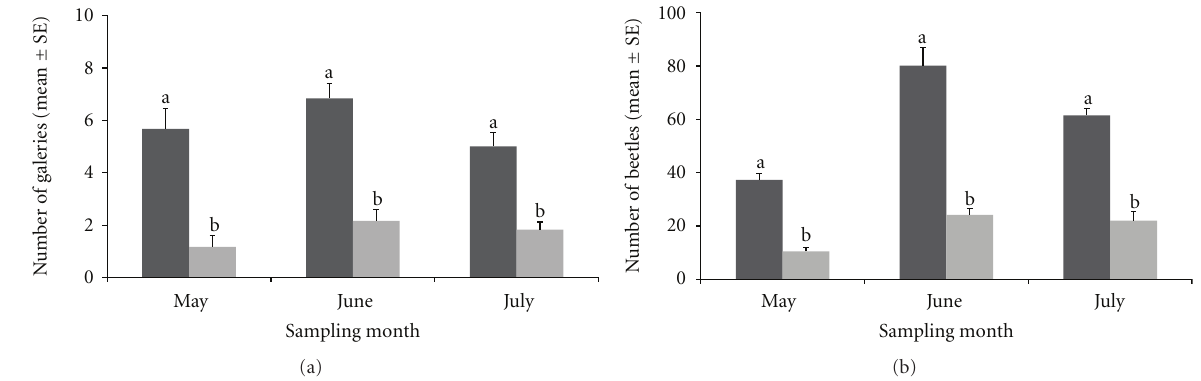
Figure 3: Number (mean ± SE) of (a) galleries and (b) Ips sexdentatus (B¨orner) (Coleoptera: Curculionidae: Scolytinae) found under the bark of Pinus pinaster Aiton (Pinales: Pinaceae) (dark grey) and Pinus radiata D. Don (Pinales: Pinaceae) (light grey) logs from May to July ( n = 28). Means within each month with di ff erent letters are significantly di ff erent at a significance level of α = 0 . 05.